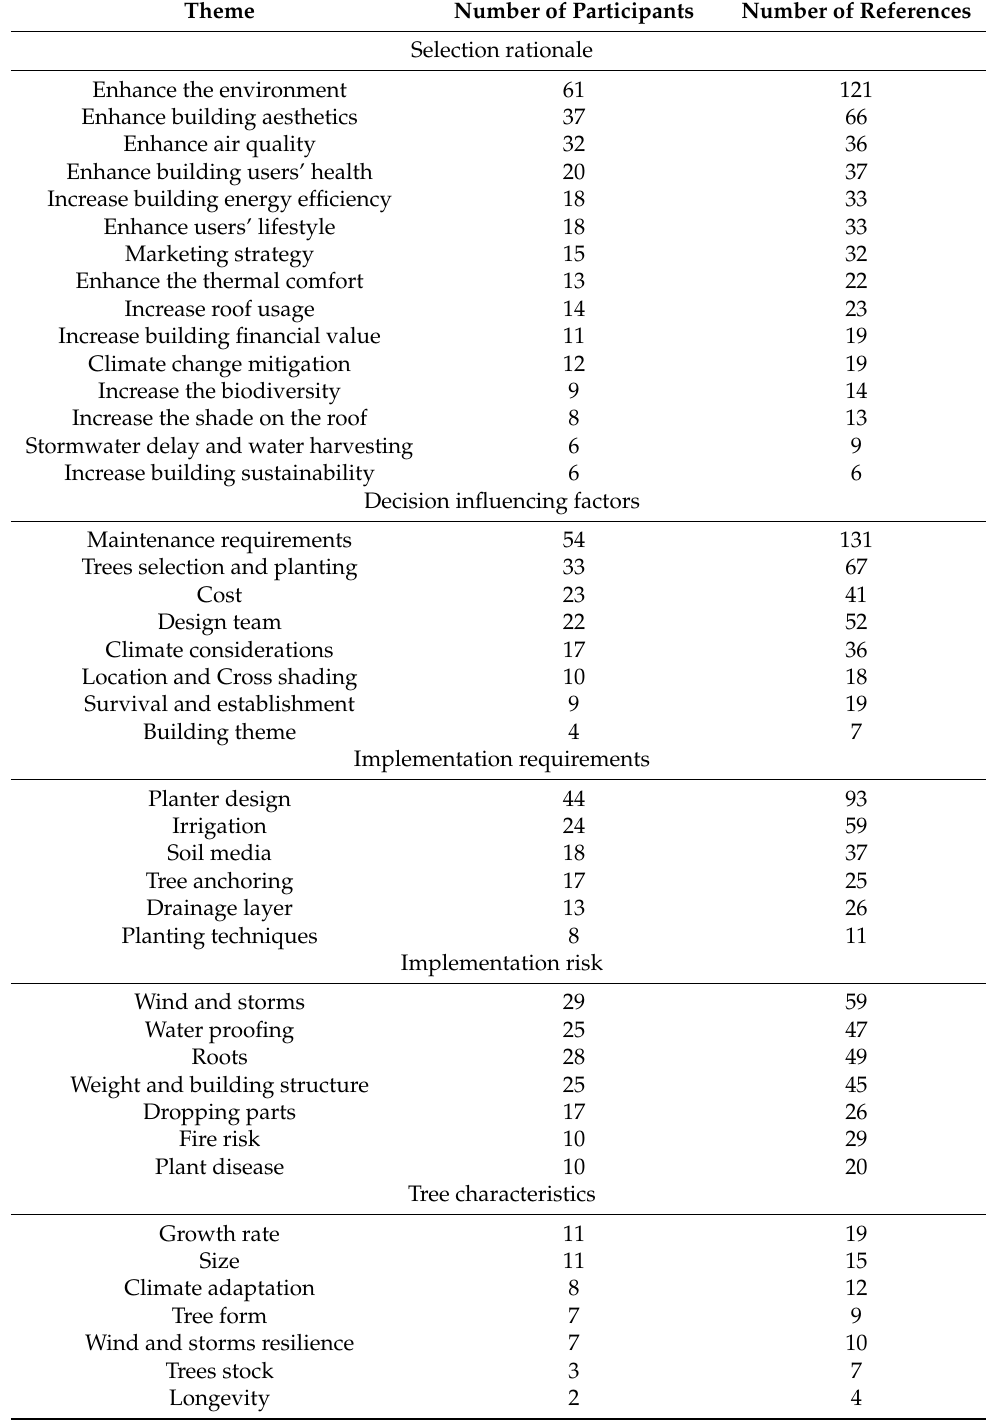
Table 1. Coding themes of the survey results using NVivo showing the number of the participants and references in each